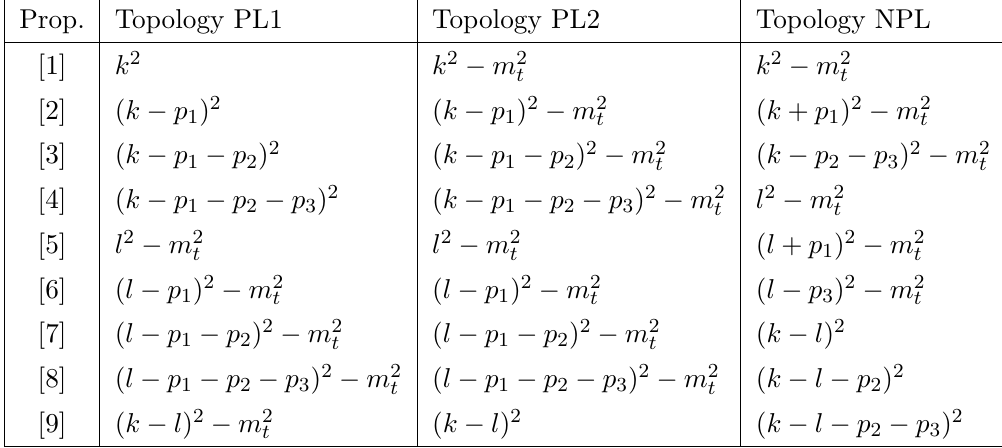
Table 1 . Feynman propagators of the three integral families, see eq.